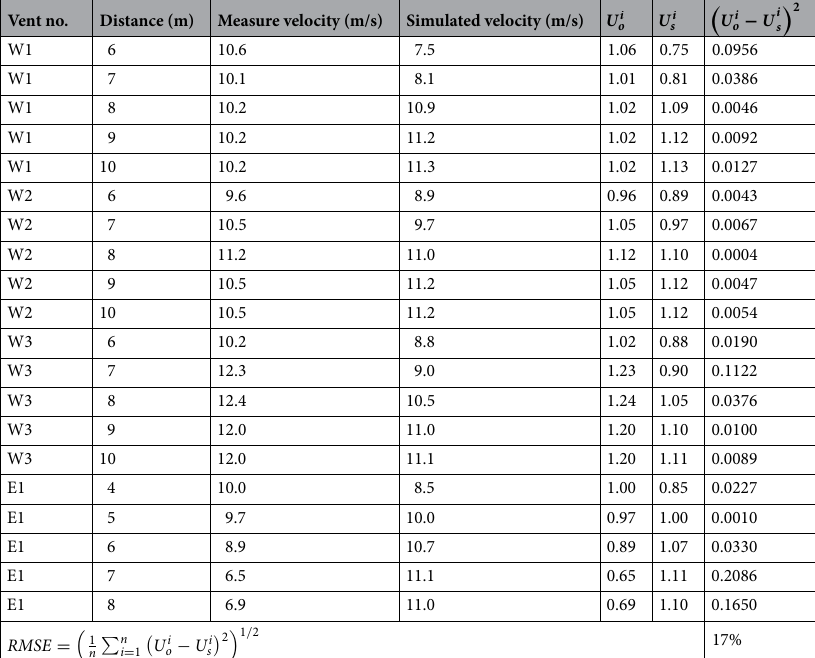
Table 1. Validation in the windmill model.